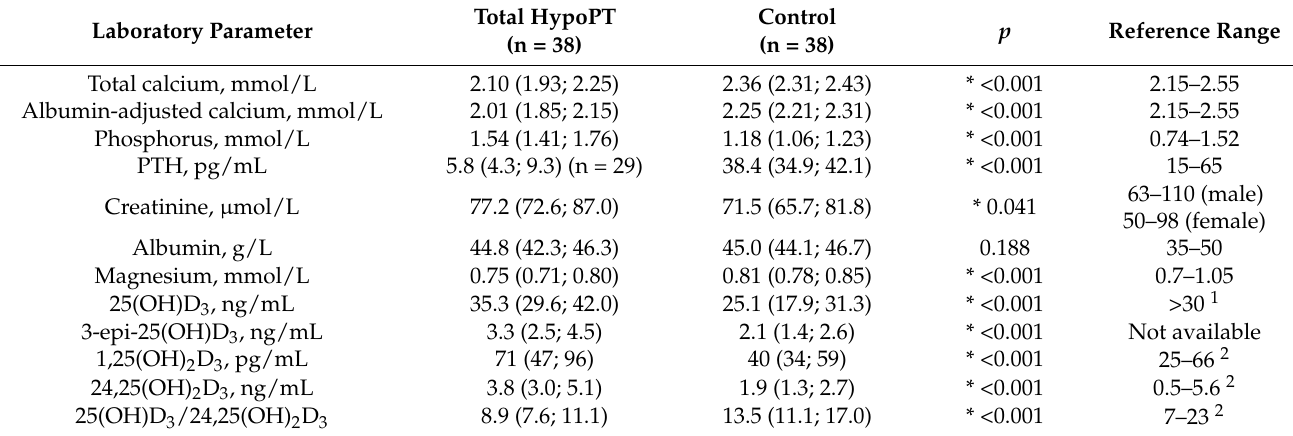
Table 3. Results of the laboratory evaluation in hypoparathyroidism and control